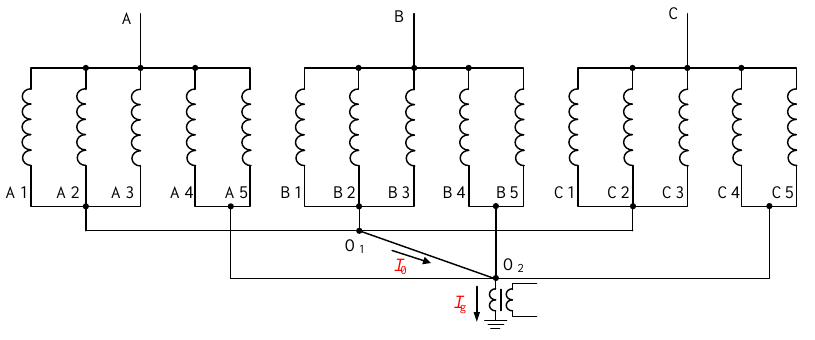
Figure 2. Schematic of the multi-branch generator stator windings .